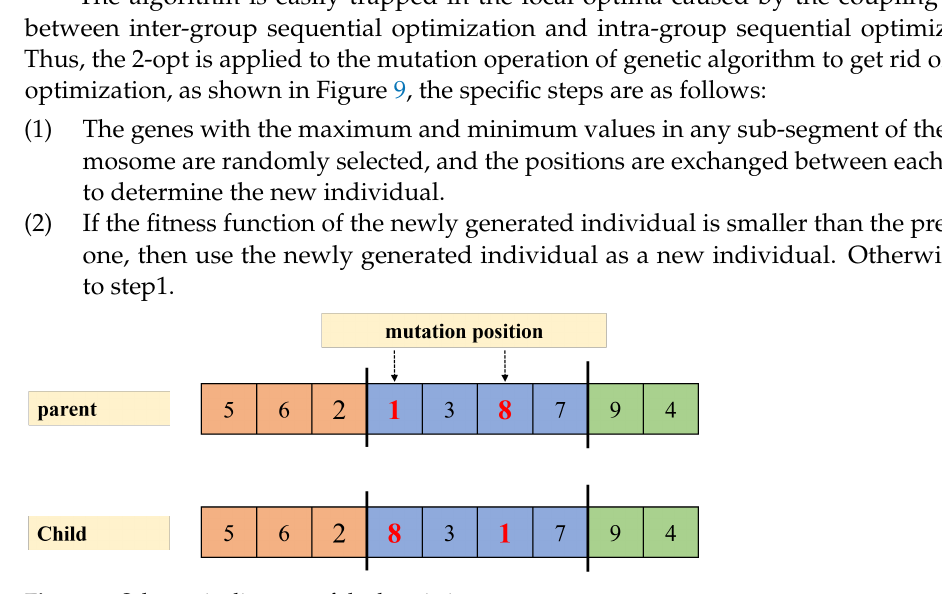
Figure 9. Schematic diagram of the heuristic